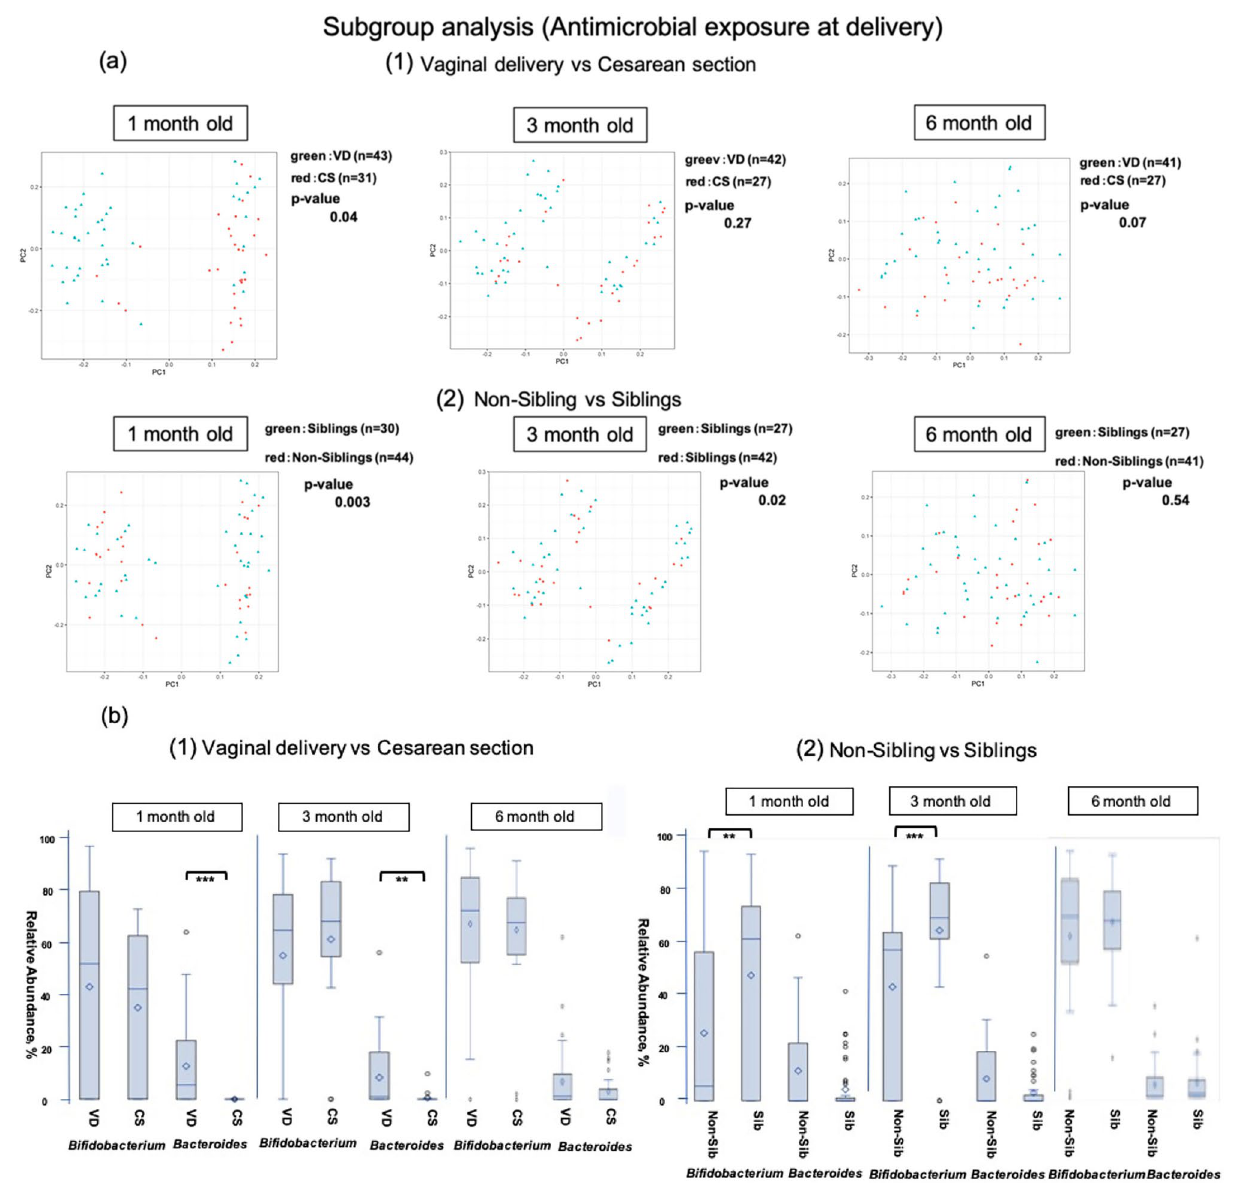
Figure 5. Comparison of the β diversity and occupancy of the top two bacteria species in the vaginal delivery (VD) and caesarean section (CS) groups of the AED group. ( a ) Comparison of β diversity of the intestinal microbiome at each age between delivery methods (1) and with and without siblings (2) in the AED group. VD: vaginal delivery, CS: caesarean section, Non-Siblings: infants without a sibling, Siblings: infants with older siblings. ( b ) Bifidobacteria and Bacteroides occupancies in the AED group compared between delivery methods (1) and presence of absence of siblings (2), shown as box-whisker plots at each age. (1) The vaginal delivery (VD) and caesarean section (CS) groups included 43 and 31 infants at 1 month (74 in total); 42 and 27 infants at 3 months (69 in total), and 42 and 27 infants at 6 months (68 in total). (2) The Sib and non-Sib groups included 44 and 30 infants at 1 month (74 in total), 42 and 27 infants at 3 months (69 in total), and 41 and 27 infants at 6 months (68 in total). The significance level was set at 5%. ** p < 0.01, *** p < 0.001 using Mann–Whitney U-test. This figure was generated using SAS version 9.4 (https